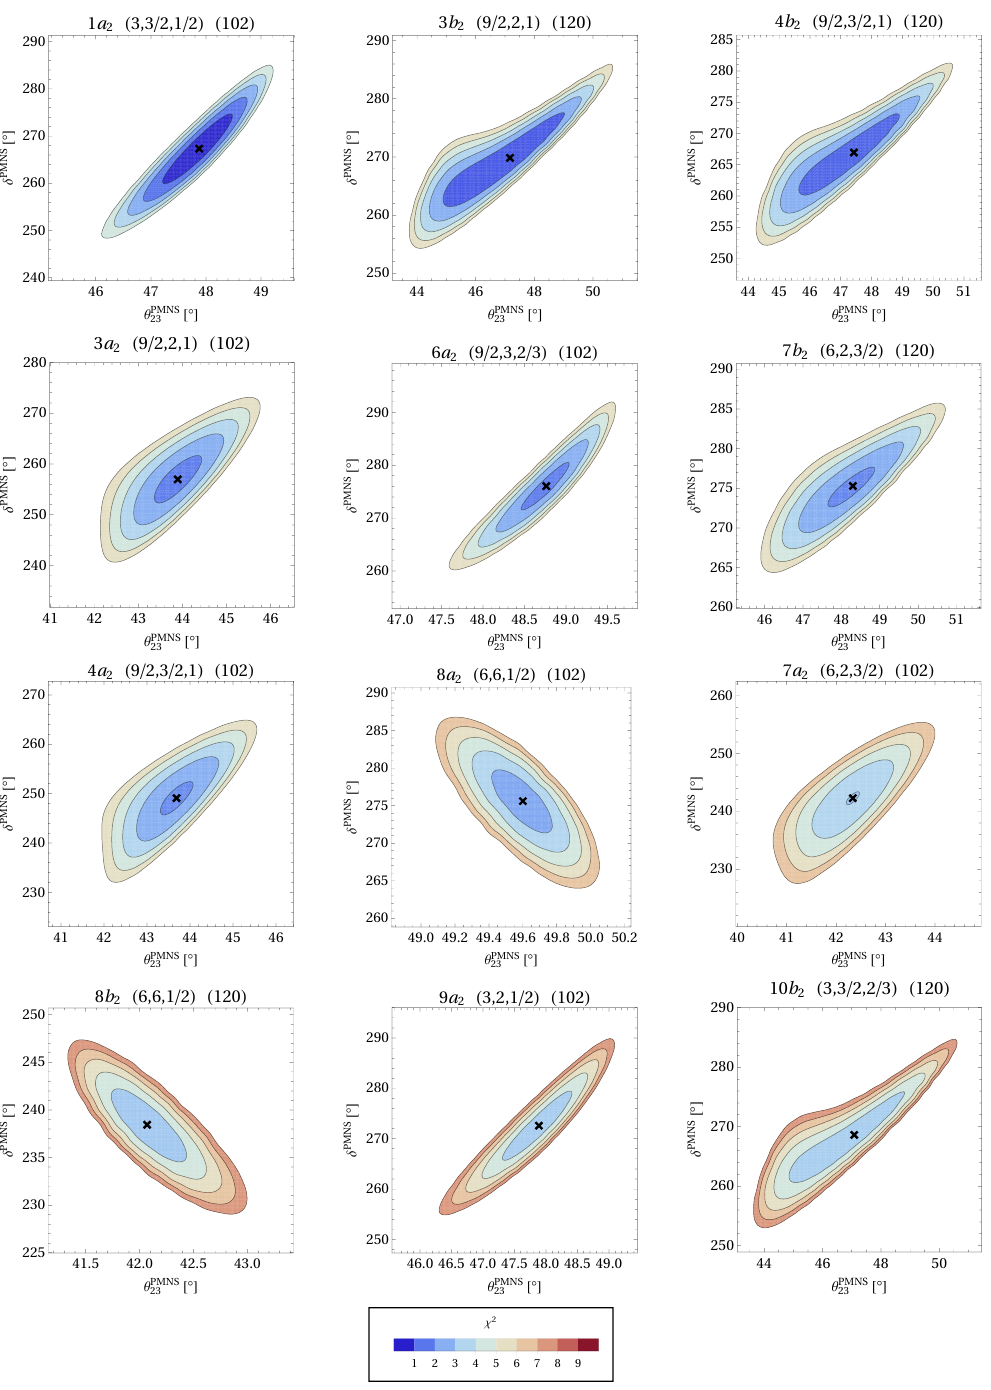
Figure 3 . Minimal (cid:31) 2 contours of the best (cid:12)t models in the (cid:18) PMNS { (cid:14) PMNS plane. From top left 23 to bottom right the 12 best (cid:12)t points with lowest (cid:31) 2 from table 3 are presented. In each plot the minimal (cid:31) 2 for (cid:12)xed (cid:18) PMNS and (cid:14) PMNS is plotted as contours around the local minimum, indicated 23 by a black cross. Beside the chosen CG coe(cid:14)cients ( c x ; c y ; c z ) and the CSD2 variant ( Y (102) (cid:23) or Y (120) (cid:23) ), the title of each plot contains a label specifying the best (cid:12)t point according to table 3. Only local minima with (cid:14) PMNS within the experimental 3 (cid:27) range are chosen.